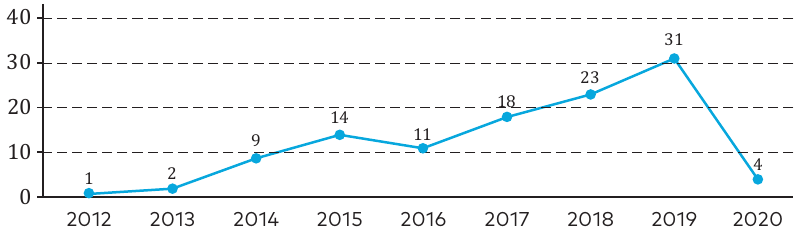
Figure 2. The research steps for a bibliometric analysis of the retrieved papers (created by the